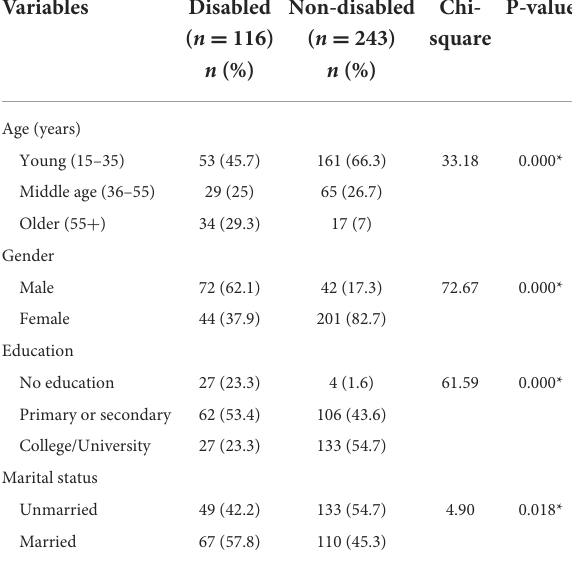
TABLE 1 Demographic characteristics of the study